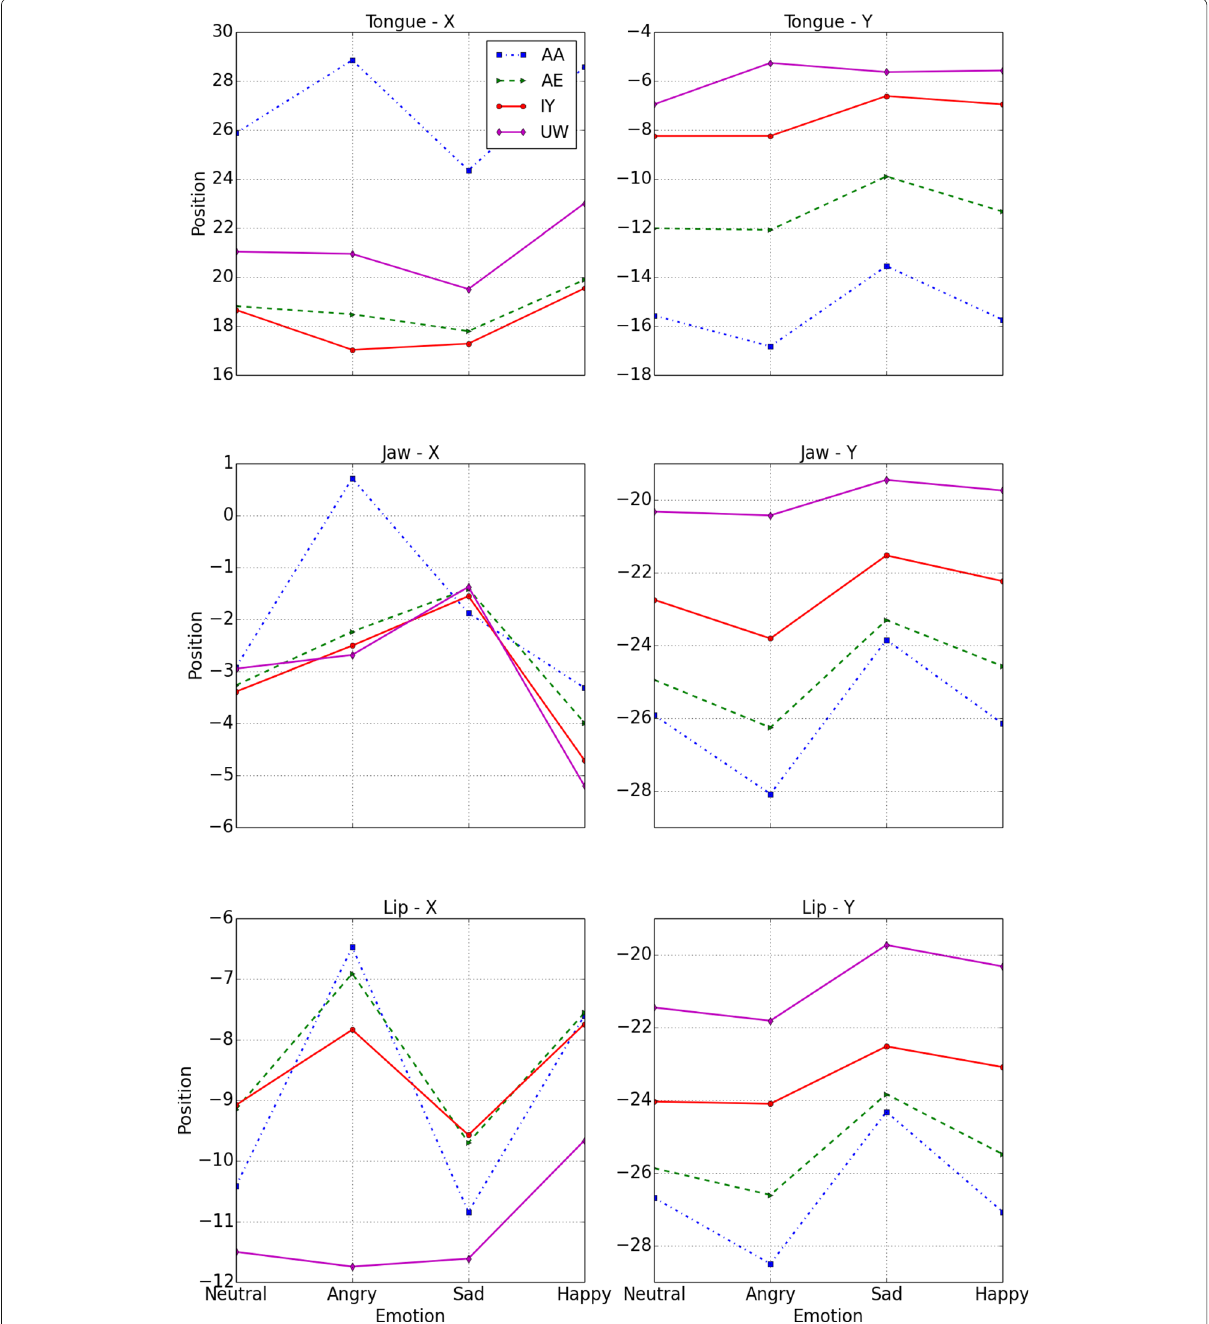
Fig. 2 Mean position of select articulatory targets, averaged across all speakers, for different vowels and emotions in the USC EMA database. (Top row) Tongue, (middle row) jaw, and (middle row) lip. Negative axis corresponds to forward movement along X -axis and downward movement along Y